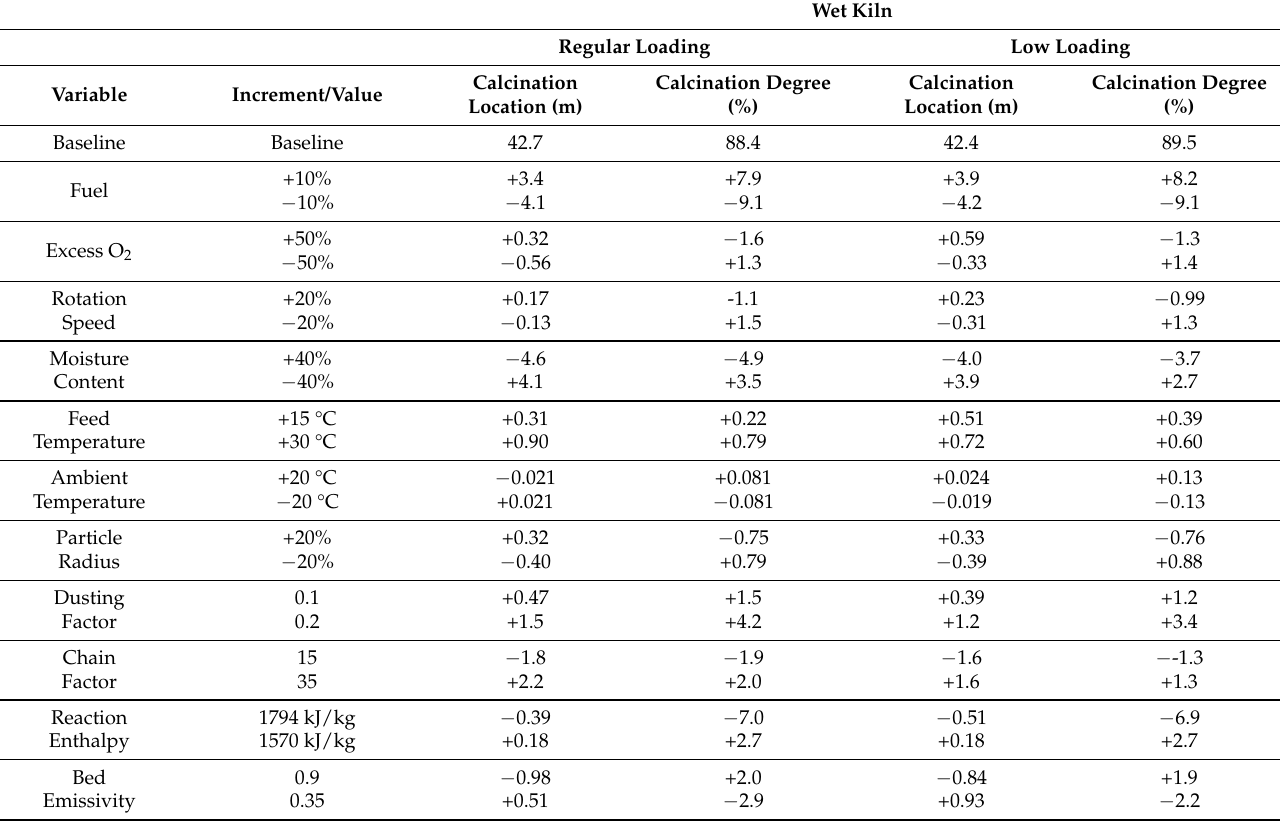
Table 7. Regular and low loading comparison for wet